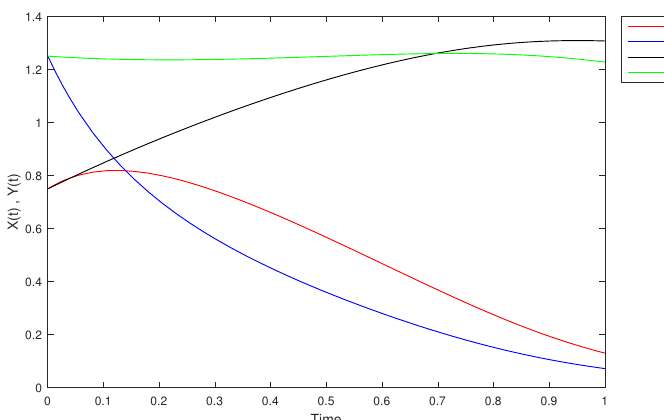
Figure 28. The solution of (13) at α = 0.0 as time increases. At α -level = 0 , the solution is unstable since as t → ∞ , u ( t ) → 0.1744 , v ( t ) → 0.1179, r ( t ) → 0.5308 , s ( t ) → 0.2155. α -level = 0.5 is shown in Figures 29 and 30: